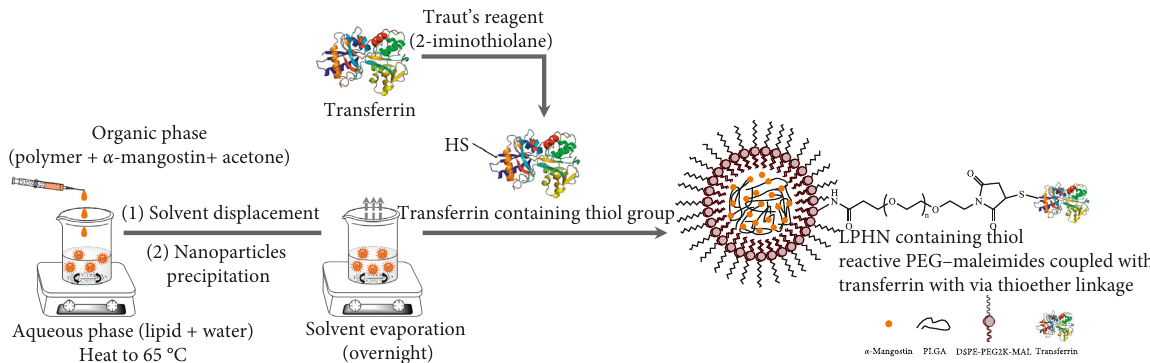
Figure 1: Preparation of α -mangostin-loaded transferrin-conjugated lipid-polymer hybrid nanoparticles.